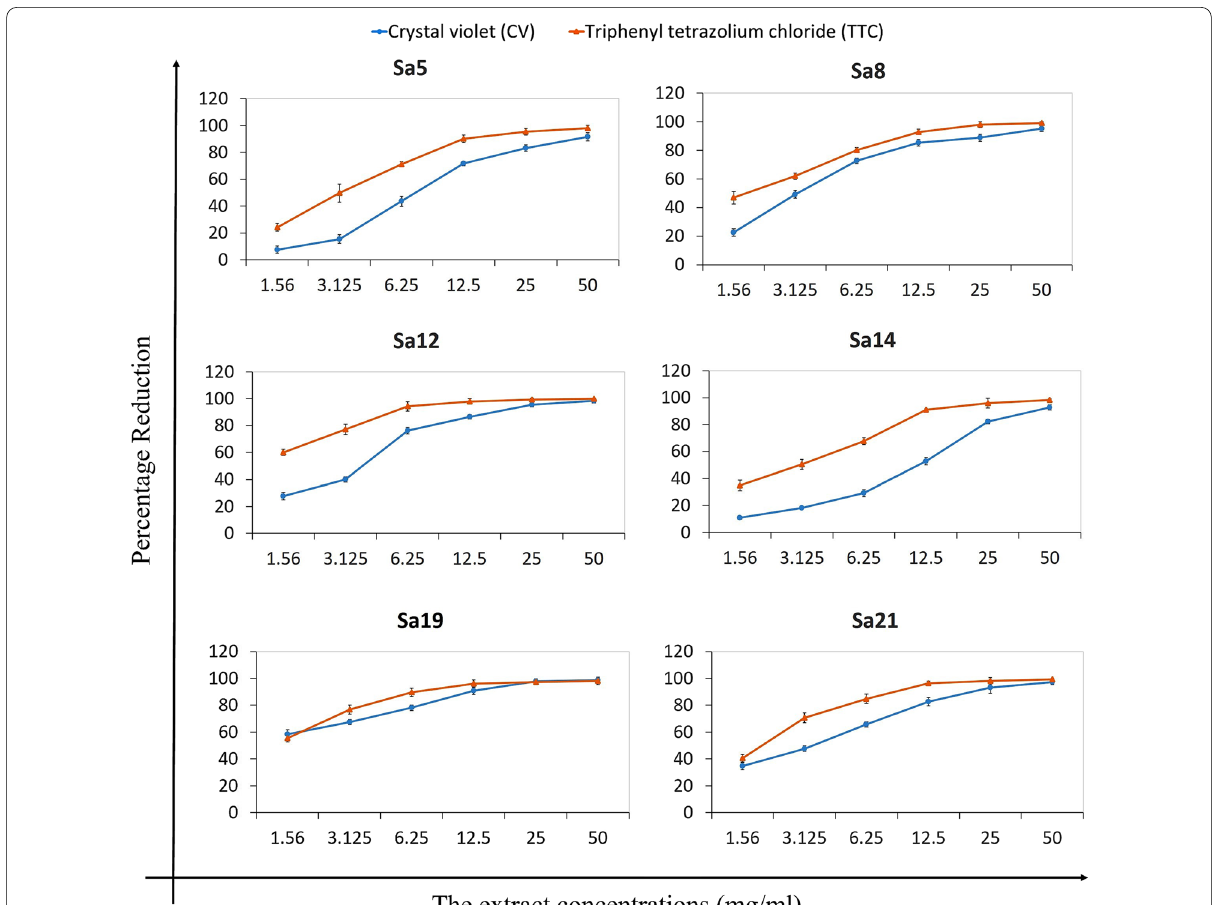
Fig. 2 The percentage of reduction of viable bacterial cells (log10 CFU/mL) after exposure to sub-MIC concentration (0.098 mg/ml) of the M. communis extract